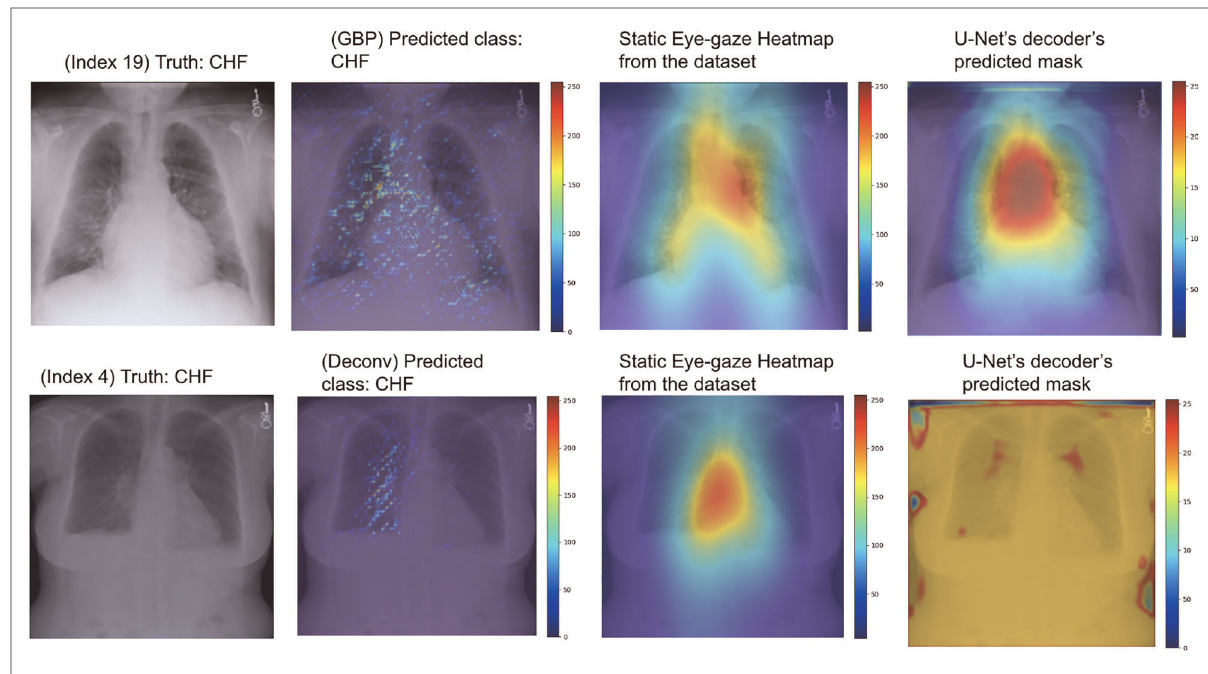
FIGURE 11 Model ’ s output heatmaps using GBP (top) and deconvNet (bottom) as the heatmap generator for Experiment Set 3 for the correctly classi fi ed CHF